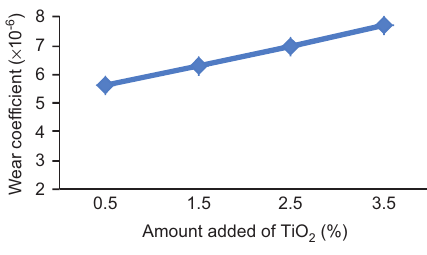
Figure 3 Variation of the hardness of the cast composites with increasing TiO particle 2